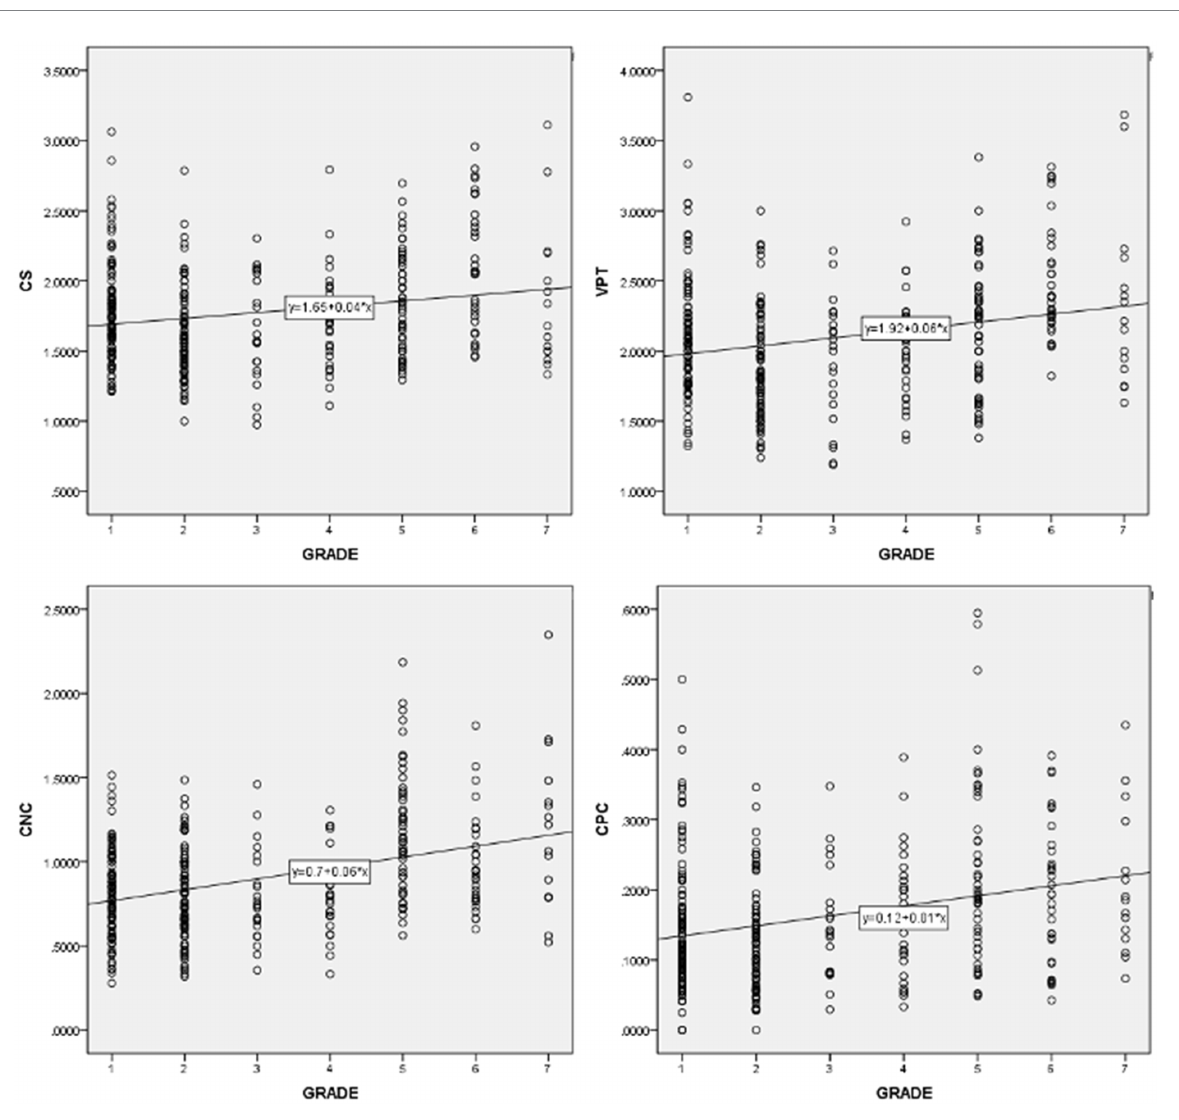
FIGURE 2 Scatter diagrams of indices which have weak correlations with grade.